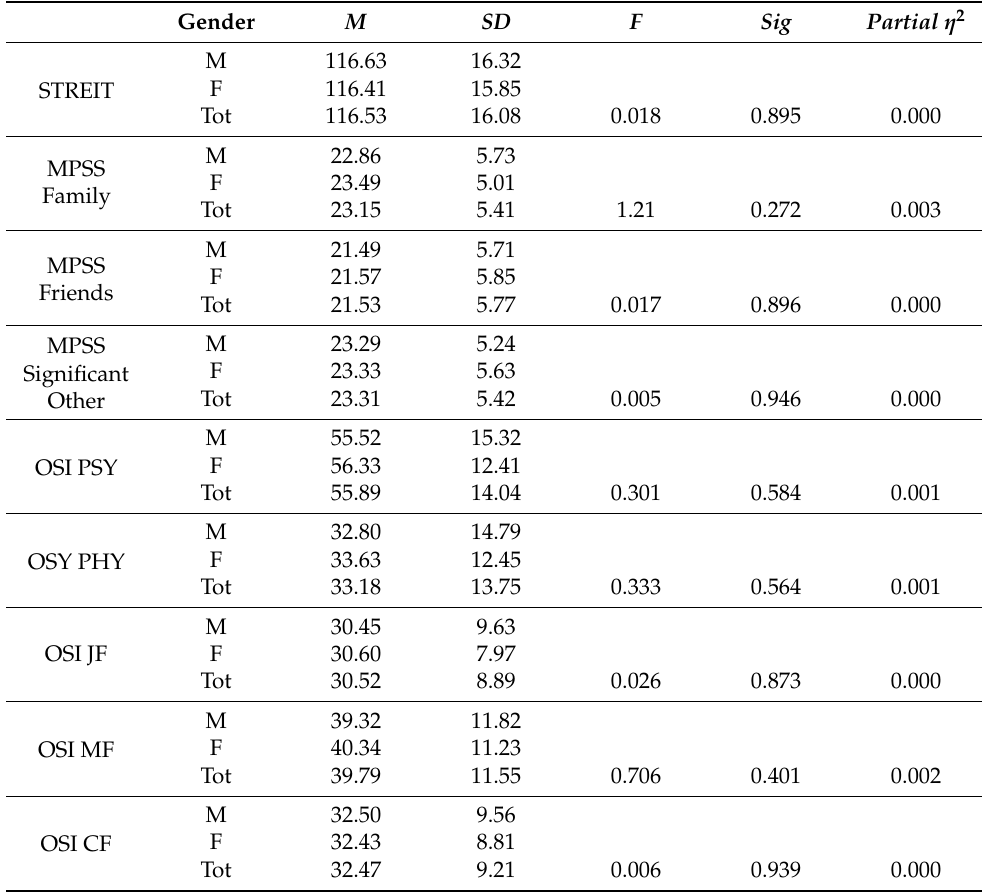
Table 3. Scores obtained by men and women on the study